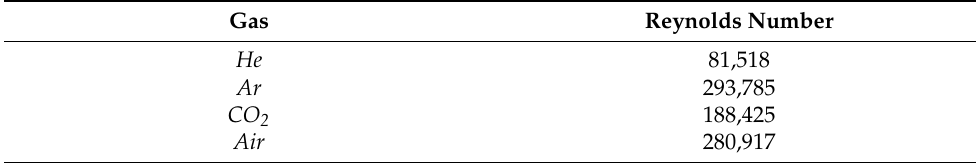
Table 1. Reynolds number of gases.